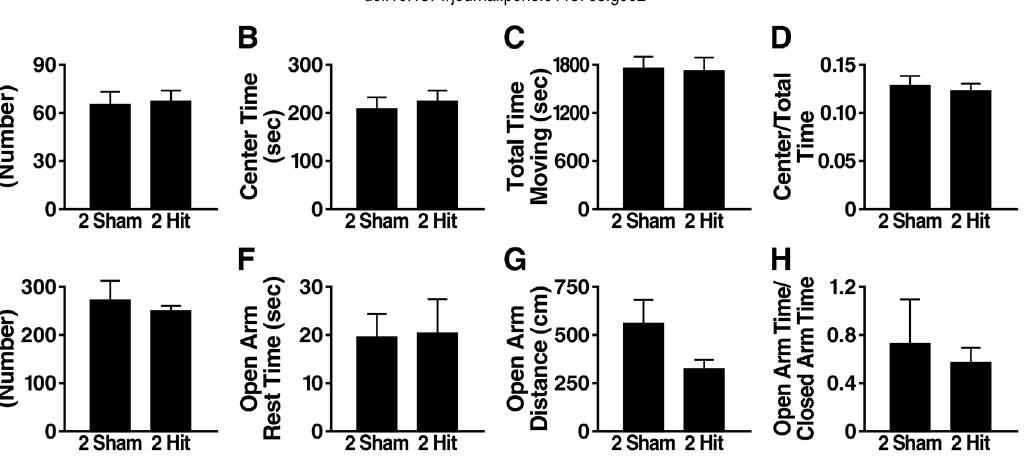
Fig. 3. Wildtype mice show no alterations in exploratory activity or anxiety-like behavior after 2-hit injury. Wildtype mice (n 5 8–10 per group) received a 2-hit frontal impact injury or sham treatment, followed by assessment in different behavioral tests. (A–D) Open field activity 2 weeks post-injury. (E–H) Behavior in elevated plus maze 4 weeks post-injury. Student’s t test revealed no significant differences between the 2-hit and sham treated groups for any of the tests and outcome measures. Data are means ¡